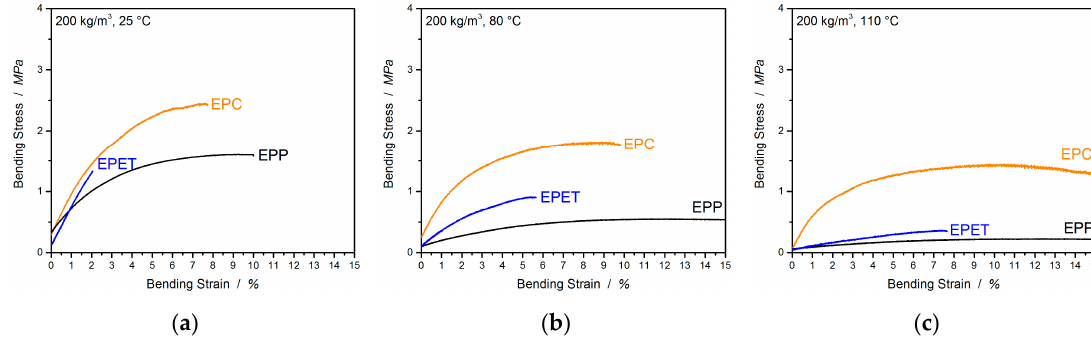
Figure 10. Three-point-bending curves for EPC, EPP, and EPET at 25 ( a ), 80 ( b ), and 110 °C ( c ).